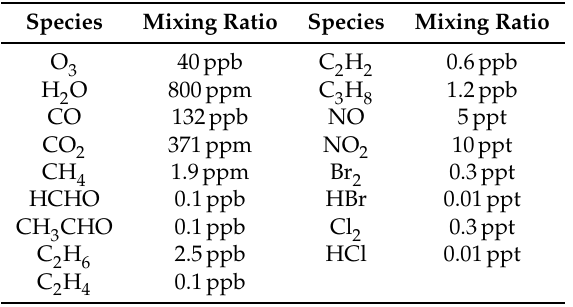
Table 1. Initial atmospheric composition used in the present model study, adopted from Cao et al. [44] (ppm = part per million, 10 − 6 mol/mol).